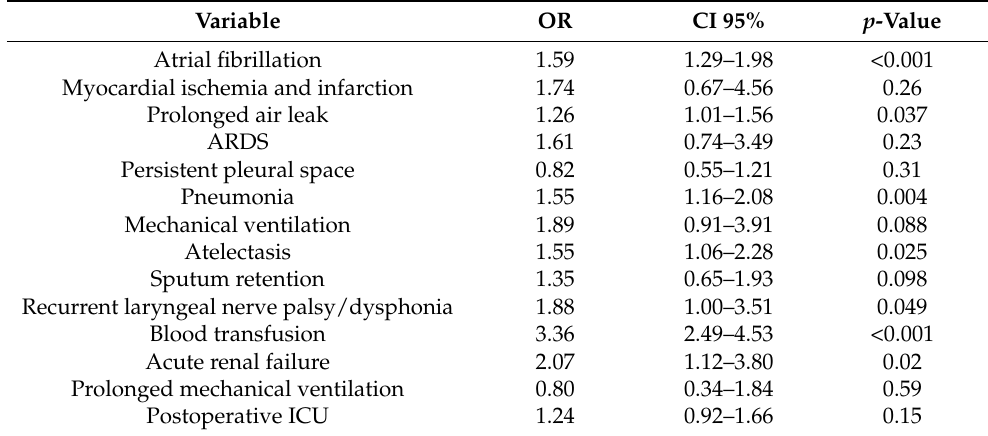
Table 4. Multivariable logistic regression model of complications associated with unplanned thoraco- tomy. ARDS = adult respiratory distress syndrome; CI = confidence interval; ICU = intensive care unit; OR = odds ratio. Variable OR CI 95% p -Value Atrial